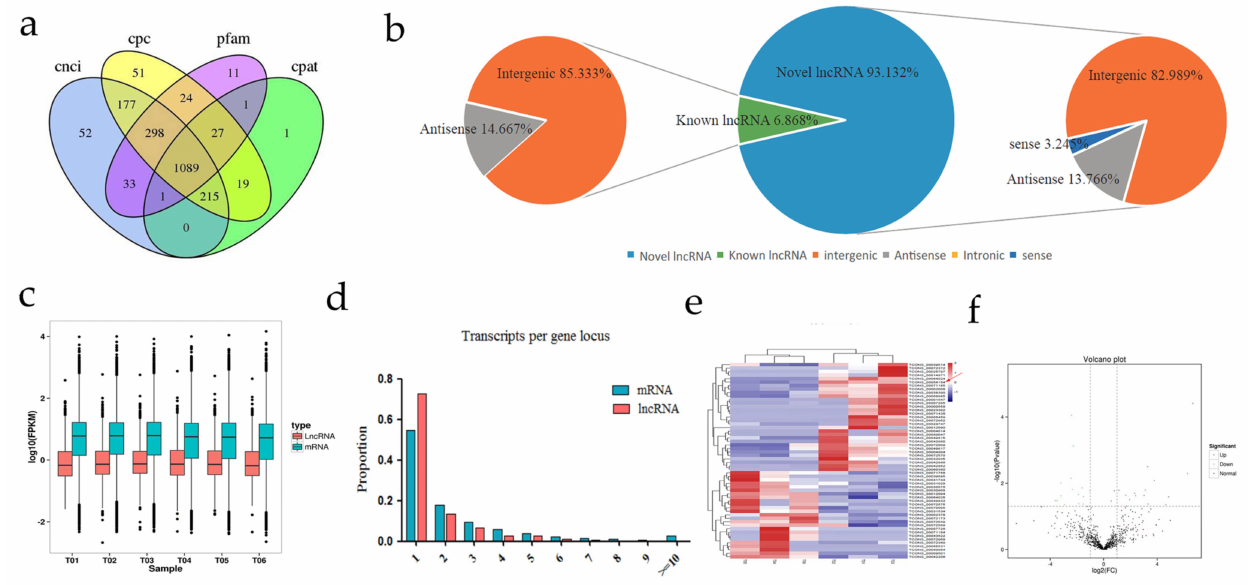
Figure 3. Identification of lncRNAs. ( a ) Screening candidate lncRNAs of the chicken skin transcrip- tome. Venn diagram of four lncRNA identification tools (CNCI, CPAT, CPC, and Pfam). ( b ) Clas- sification of lncRNAs. ( c ) The horizontal and vertical axes represent the molecular type and log10 (FPKM), respectively. The boxes represent the quantile numbers. ( d ) The proportion of isoforms of lncRNAs and mRNAs at a different locus. ( e ) Hierarchical clustering of differentially expressed lncRNAs. ( f ) Volcano plot of the differentially expressed lncRNAs between YS and BS are